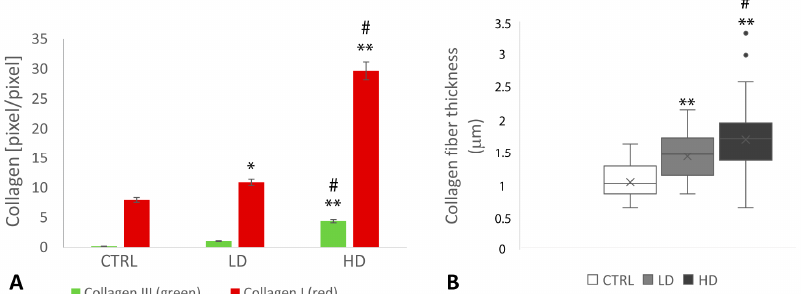
Figure 3. ( A ) Quantitative examination of polarized light images of PSR-stained micrographs. Comparison of mature and immature collagen deposition in high dose (HD) and low dose (LD) vs. control (CTRL) (* p < 0.05; ** p < 0.001); HD vs. LD (# p < 0.001). ( B ) Mean collagen fiber diameter in HD- and LD-treated samples compared with the control group. HD and LD vs. CTRL (** p < 0.001); HD vs. LD (# p < 0.001).